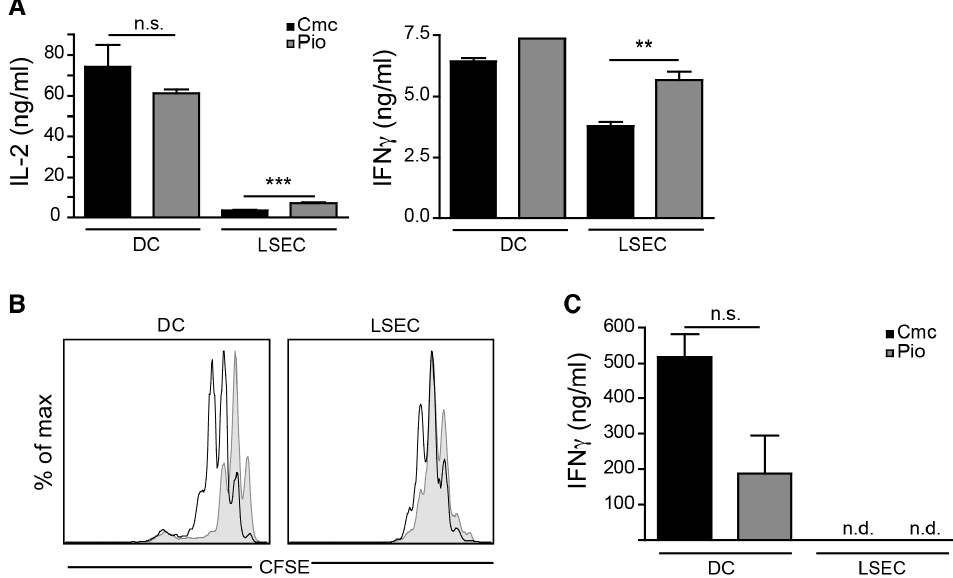
Figure 2. PPAR γ activation does not alter T cell function after priming by LSEC. C57BL/6 mice were fed for 7 days with 30 mg/kg Pioglitazone or with vehicle (cmc) alone. LSEC and dendritic cells (DC) were isolated from these mice and cocultured with purified ovalbumin (OVA)-specific CFSE-labeled OT-1 CD8 T cells in the presence of 100 μ g/mL OVA. ( A ) After 24 h, IL-2 and IFN γ release was determined by ELISA. ( B ) After 72 h, the proliferation profile of the OT-1 CD8 T cells was determined by flow cytometry (black line, no fill = cmc, grey line, grey fill = Pio). ( C ) After 4 days of coculture, CD8 T cells were re-stimulated with plate-bound anti-CD3 ε /CD28 antibodies and 24 h later, production of IFN γ was measured by ELISA. Error bars indicate mean ± SD, n = 3; one representative experiment out of three is shown. ** p ≤ 0.01, *** p ≤ 0.001, n.s. = not significant, n.d. = not detected.